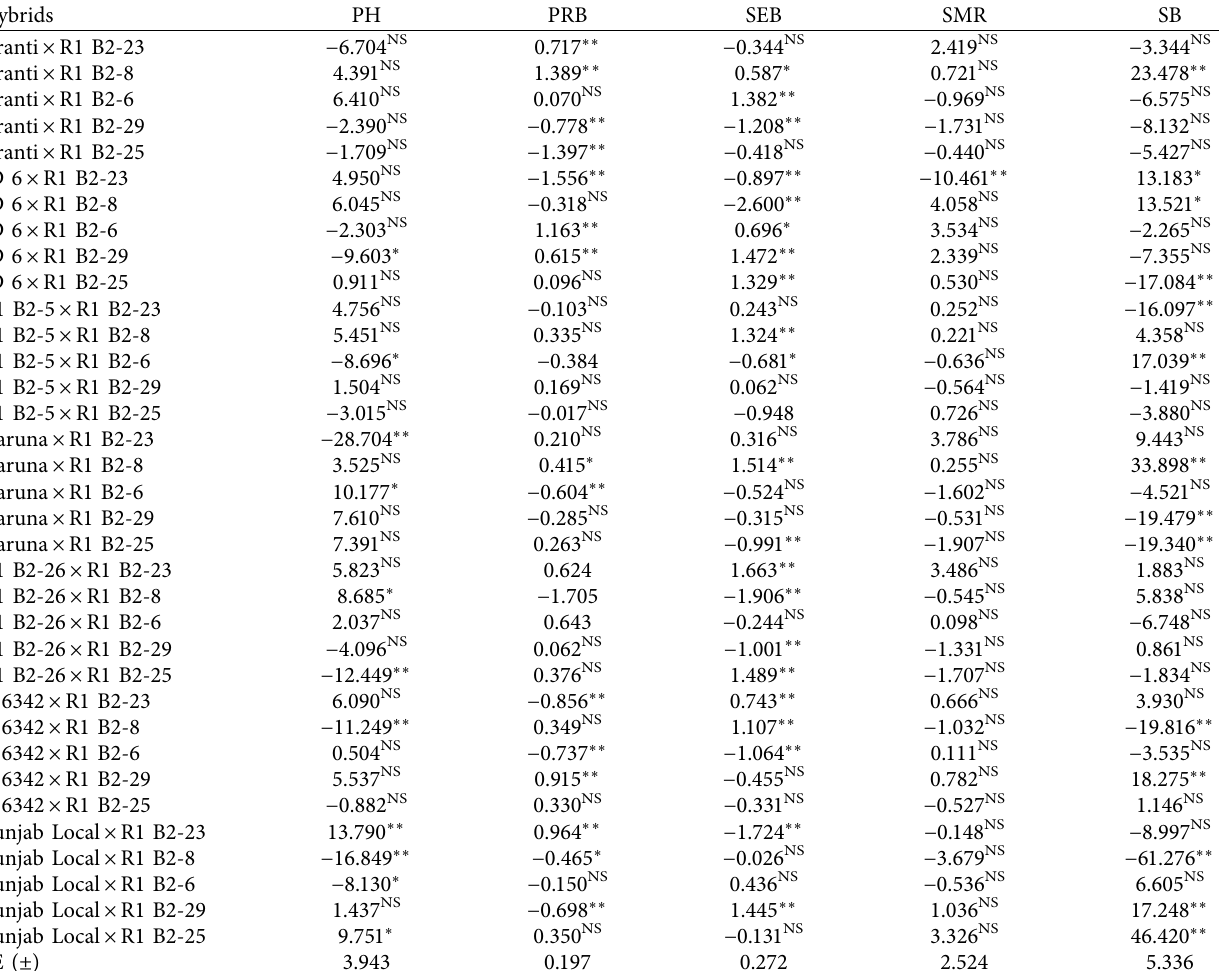
Table 8: Specific combining ability (SCA) effects of mustard hybrids on yield and its attributed